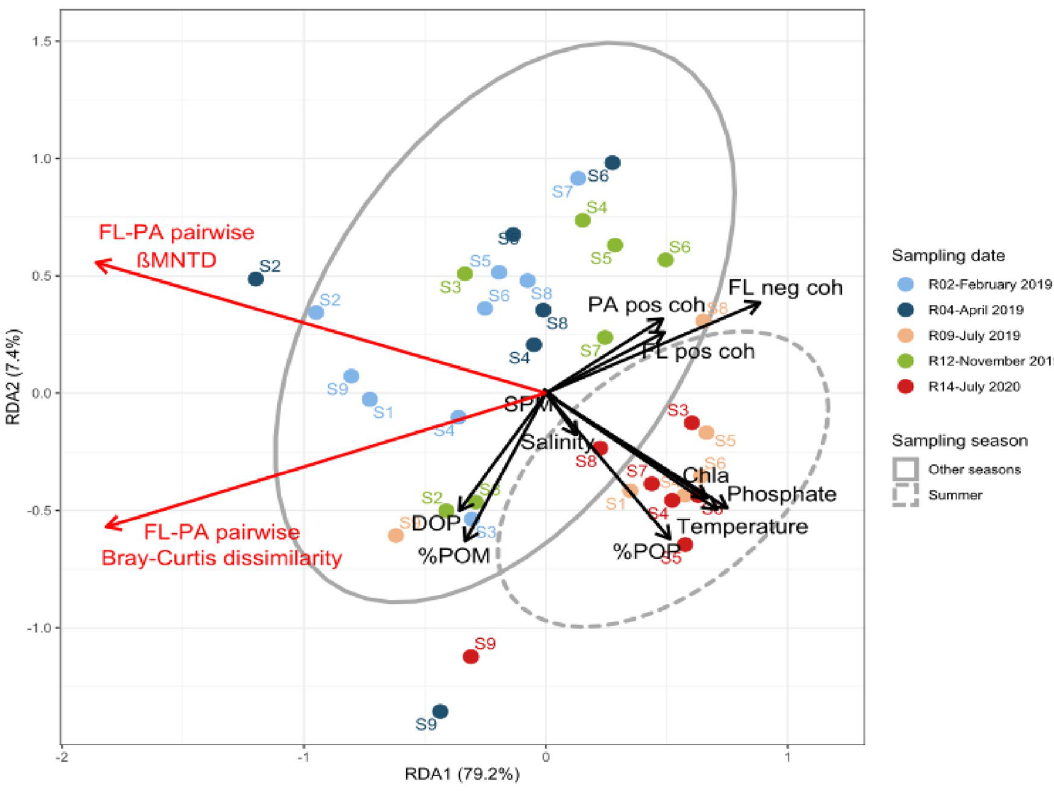
Figure 8. Redundancy analysis (RDA) of the pairwise FL-PA dissimilarity based on Bray–Curtis dissimilarity and βMNTD. The ellipses represent the sampling season (dashed line: summer, solid line: other seasons). It should be noted that the absolute value of negative cohesion was used so that the degree of negative correlation increases with the absolute value of negative cohesion. The sampling station is indicated for each sample. Pos: positive; neg: negative; coh: